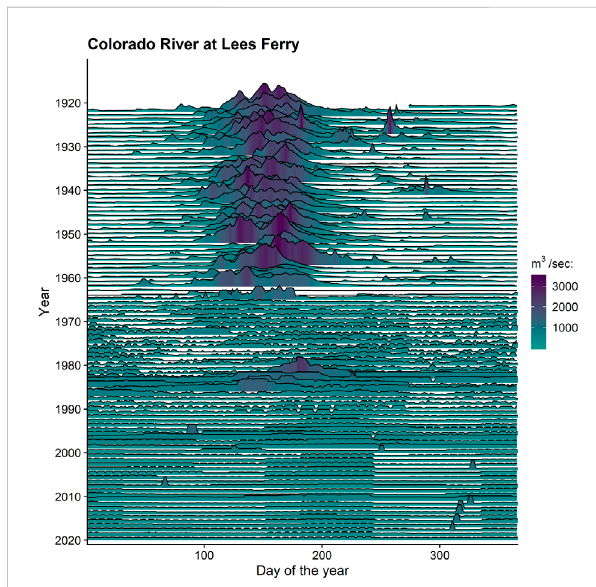
FIGURE 4 One hundred years of annual hydrology (daily mean discharge, m 3 /second) of the Colorado River at Lees Ferry prior to and after Glen Canyon Dam construction in 1964. Data source: U.S. Geological Survey (USGS) gaging station 09380000 (US Geological Survey,